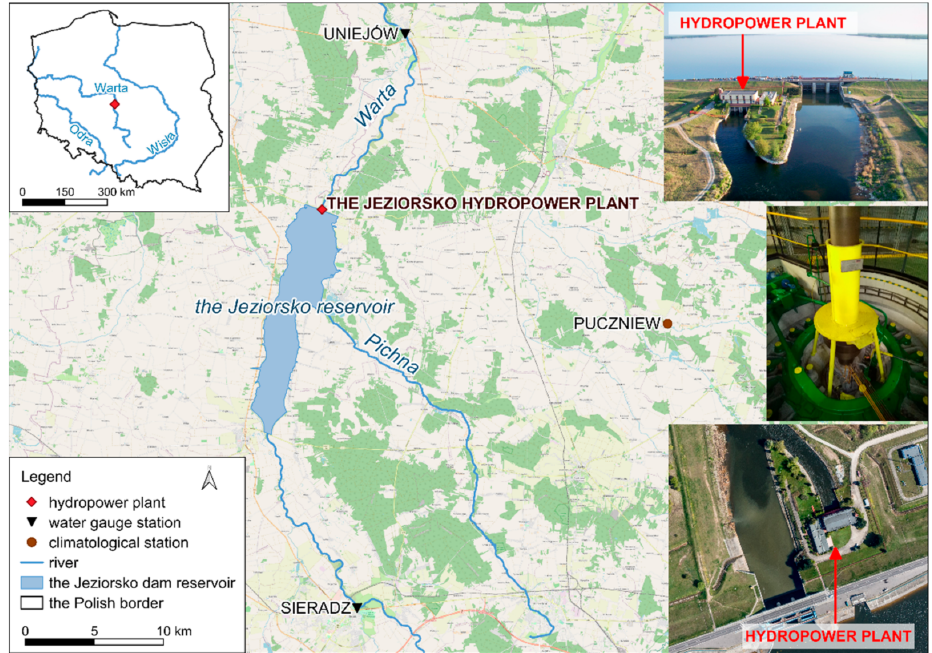
Figure 1. Location of the study